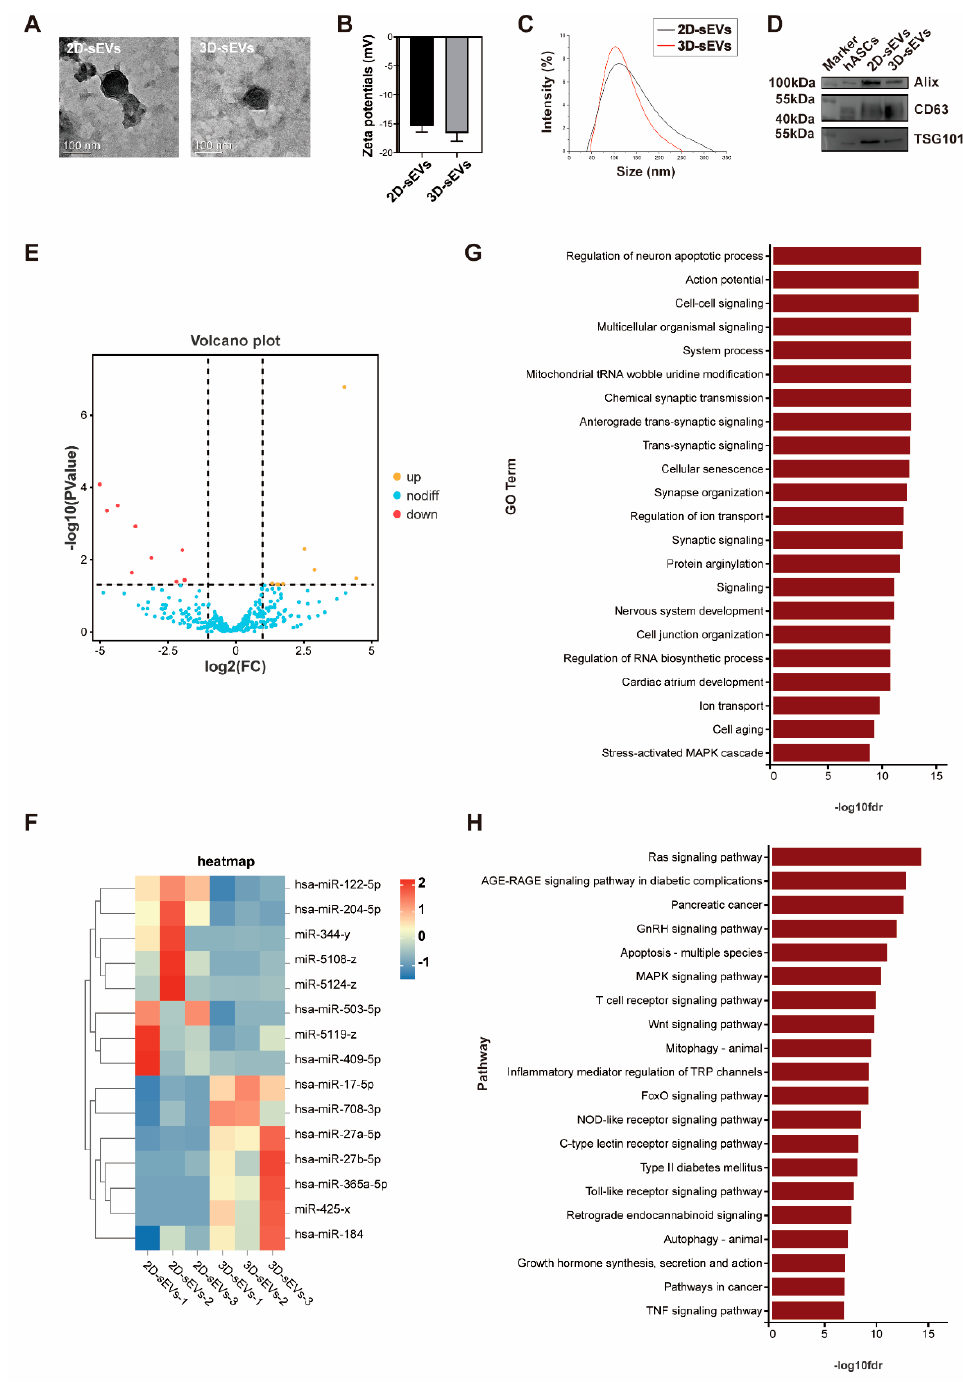
Figure 2. 3D-sEVs contains anti-photoaging miRNAs. ( A ) Representative TEM images of 2D-sEVs and 3D-sEVs. Scale bar: 100 nm. ( B , C ) The size distribution and Zeta potential of 2D-sEVs and 3D-sEVs were measured by DLS (n = 3). ( D ) Western blotting of 2D-sEVs and 3D-sEVs for Alix, CD63, and TSG101. ( E ) The volcano plot representing significance of identified miRNAs which are differentially expressed with p < 0.05. The up-regulated miRNAs are shown in yellow, while down-regulated miRNAs are shown in red. ( F ) Heatmap of differentially expressed miRNAs in 2D-sEVs and 3D-sEVs. ( G ) Gene Ontology (GO) functional analysis of the differentially expressed miRNAs in 3D-sEVs compared with the 2D-sEVs. ( H ) KEGG enrichment analysis of the differentially expressed miRNAs in 3D-sEVs compared with the